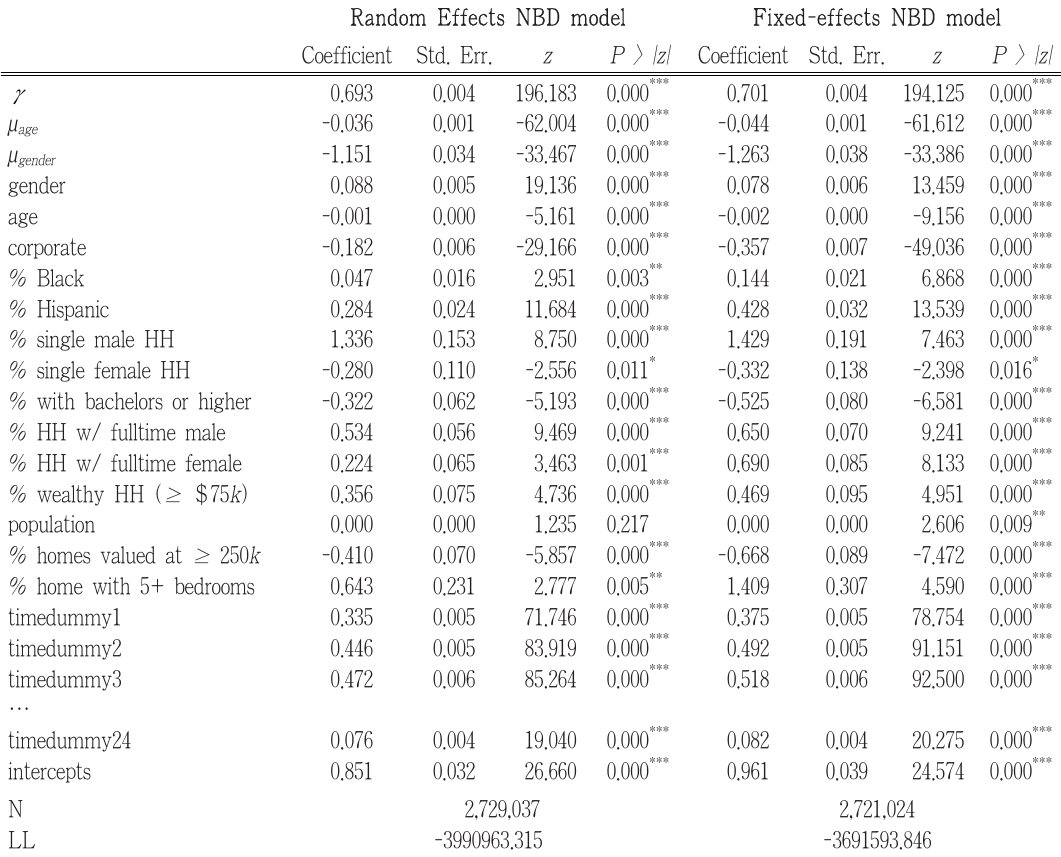
<Table 6> Negative Binomial Regression (RE vs. FE) Estimation